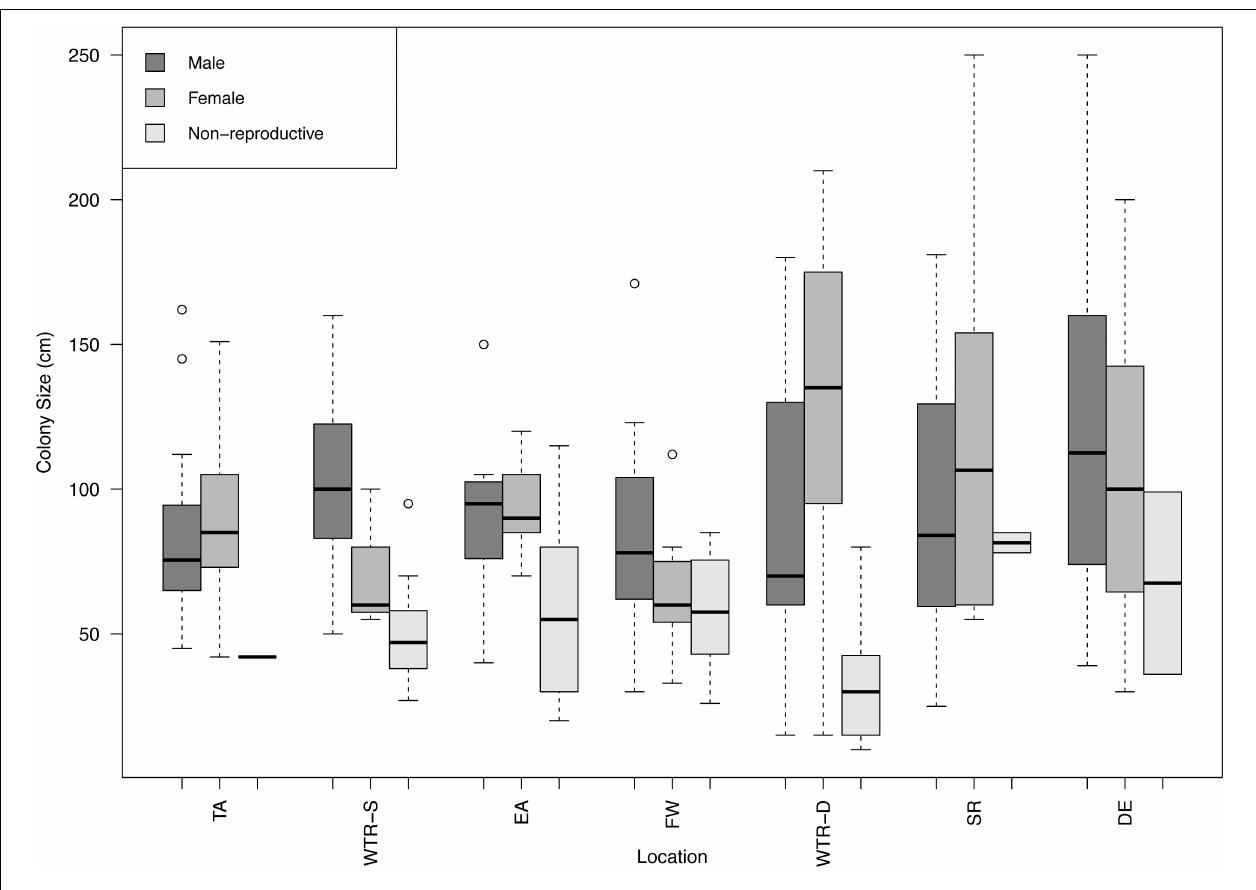
FIGURE 2 | Boxplot of male, female and non-reproductive red tree coral colony sizes at each study site. Sites are arranged from shallowest (left) to deepest (right) . Circles represent outliers in the data.